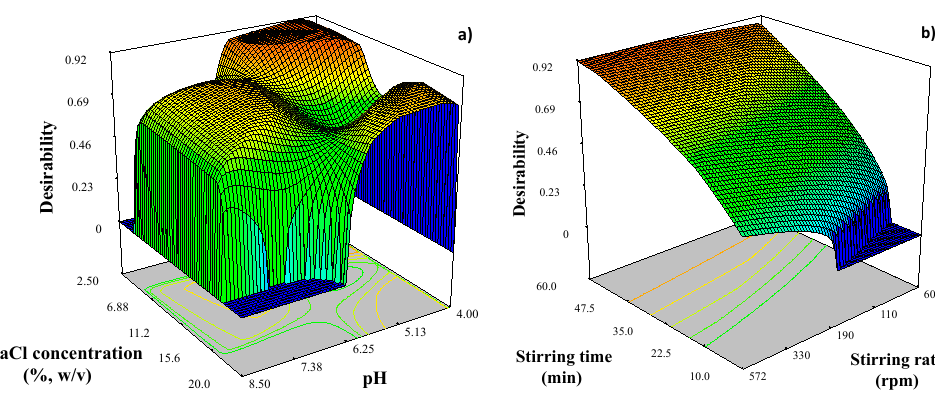
Figure 4. Response surface plots corresponding to the D function when optimizing ( a ) NaCl concentration vs. pH; ( b ) stirring time vs. stirring rate.